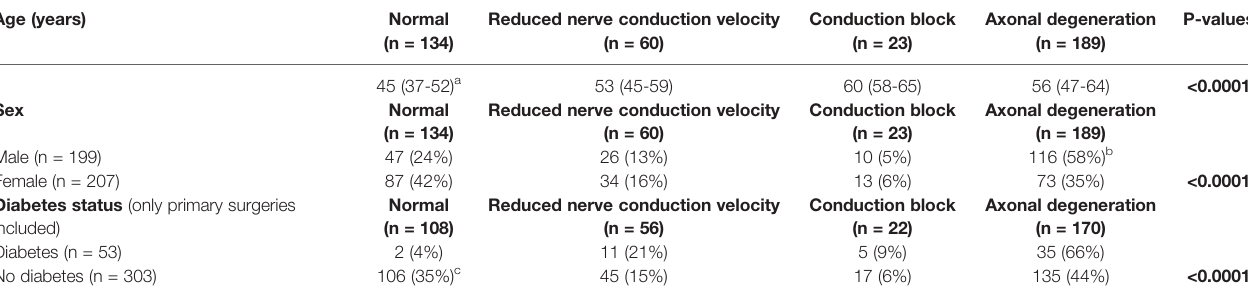
TABLE 4 | Relation between electrophysiologic grading and age of the patients, sex and diabetes (latter only primary cases) in 406 (all) and 356 (primary), respectively, surgically treated cases with ulnar nerve entrapment, irrespective of surgical method. Age (years)